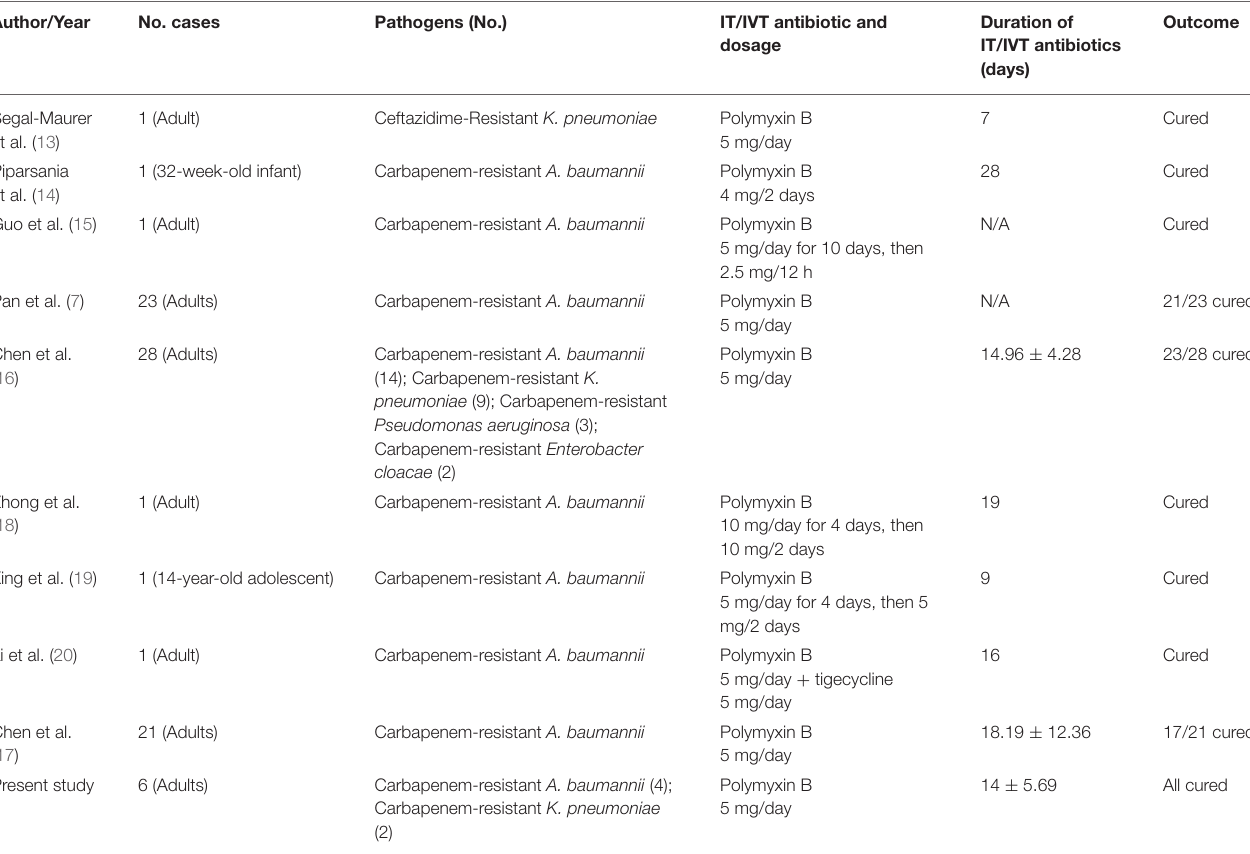
TABLE 6 | Studies of CNS infections treated with intrathecal (IT) or intraventricular (IVT) polymyxin B *